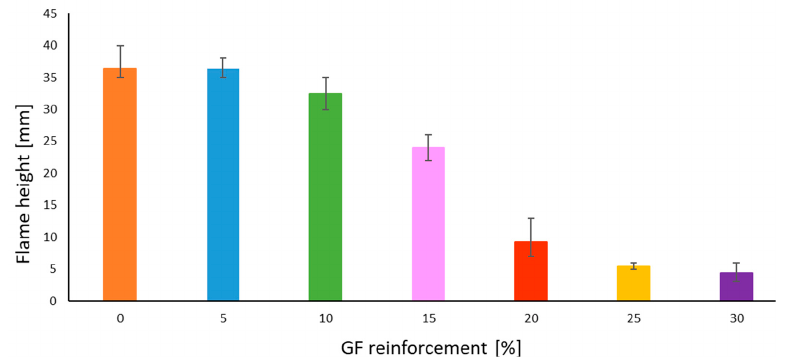
Figure 12. Bar chart of flame height vs. GF reinforcement rate with standard deviation bars.